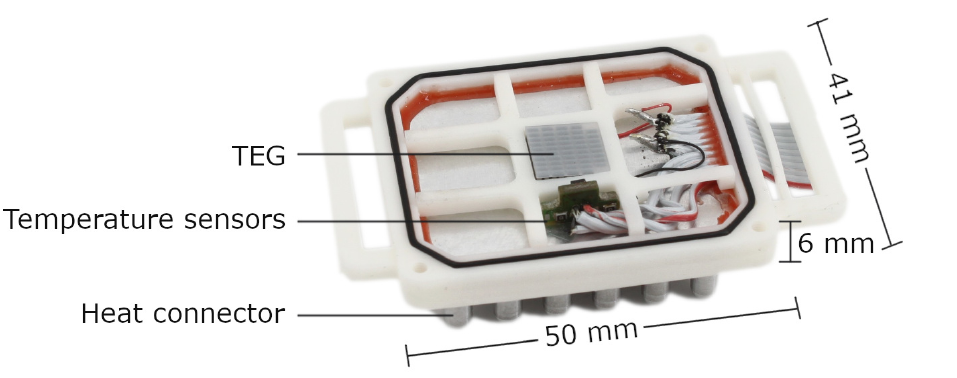
Figure 2. Housing of the harvesting part: TEG with two temperature sensors between two thermal coupling parts. The top-side heat sink is